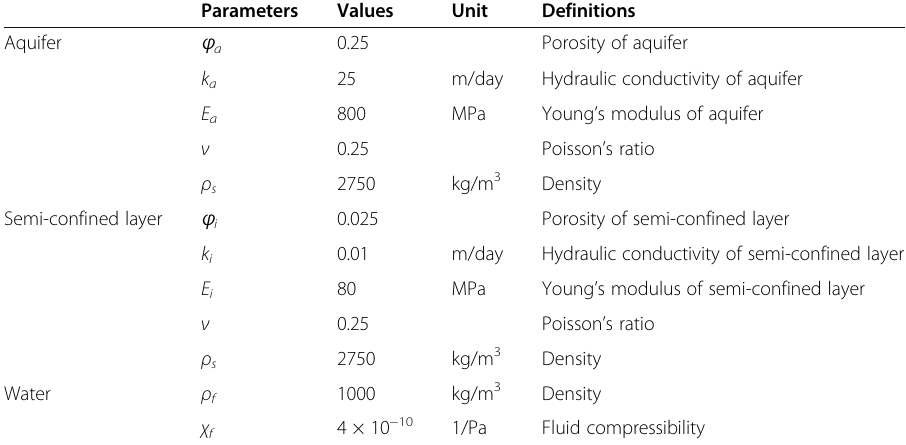
Table 1 Parameters of the numerical model and random